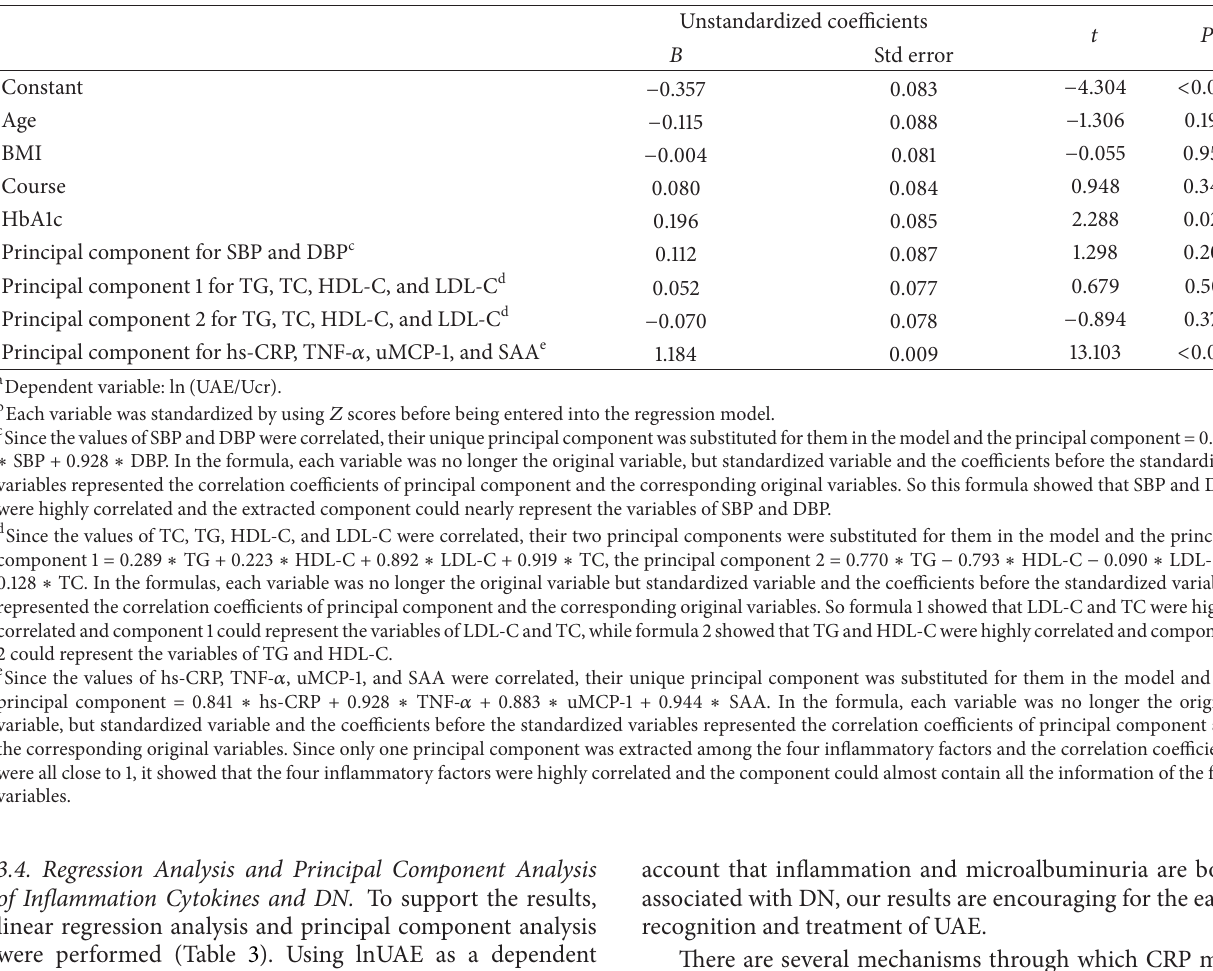
Table 3: Predictors of proteinuria in DN by multiple linear regression a,b